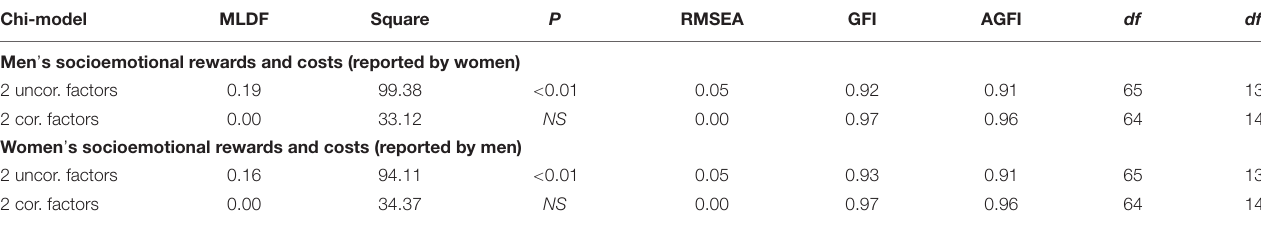
TABLE 4 | Decision tables for uncorrelated vs. correlated socioemotional reward and cost factors in the main study (initial N = 182 couples). a